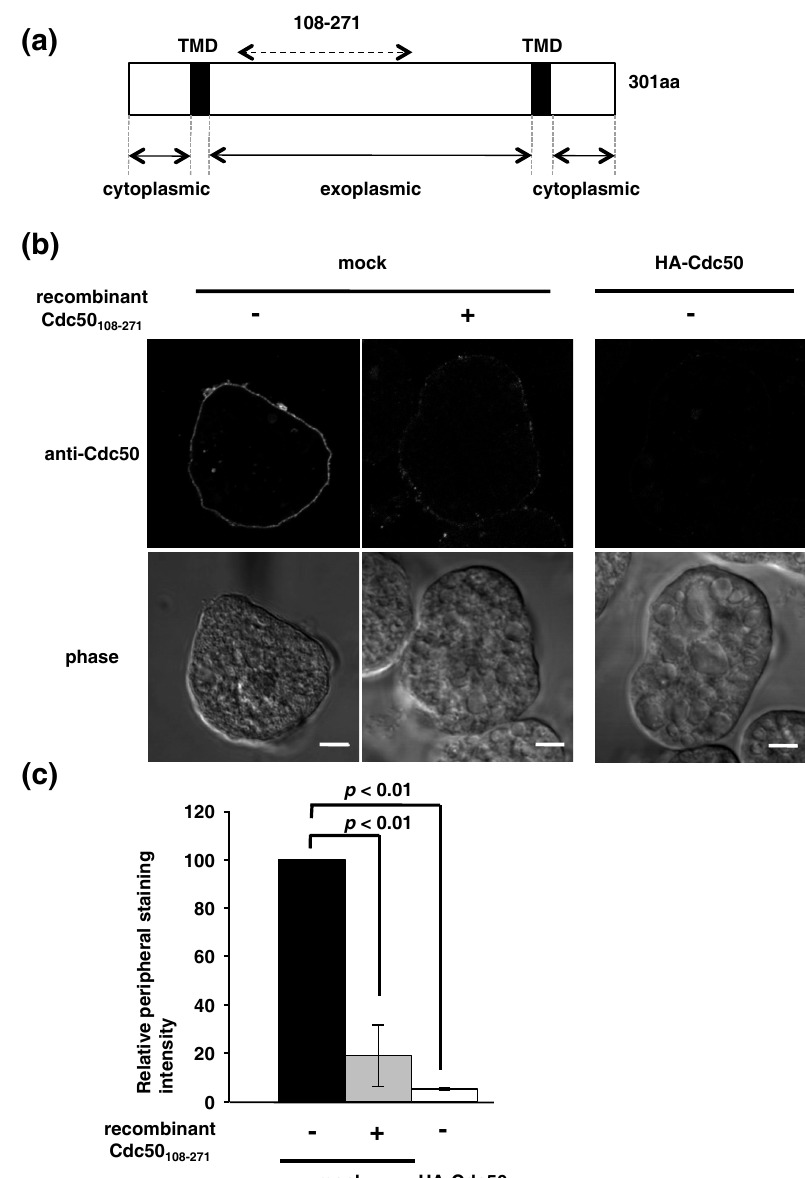
Figure 3. Surface staining of endogenous EhCdc50 in wild-type and overexpressed HA-tagged EhCdc50 cells. ( a ) Schematic diagram of the domain organization of EhCdc50. TMD, transmembrane domain. A part of the exoplasmic domain (a.a. 108–271) that was used to produce E. coli recombinant protein to raise antiserum is indicated with a dotted arrow. ( b ) Indirect immunofluorescence assay of endogenous EhCdc50 in mock control and HA-tagged EhCdc50-expressing cells without permeabilization with Triton X100. Pretreatment of the EhCdc50 antiserum with the recombinant protein (middle panel) abolished the surface labeling. Scale bar, 5 µm. ( c ) Quantification of surface labeling with anti-EhCdc50 antibody shown in ( b ). Peripheral signal intensity of 30 independent